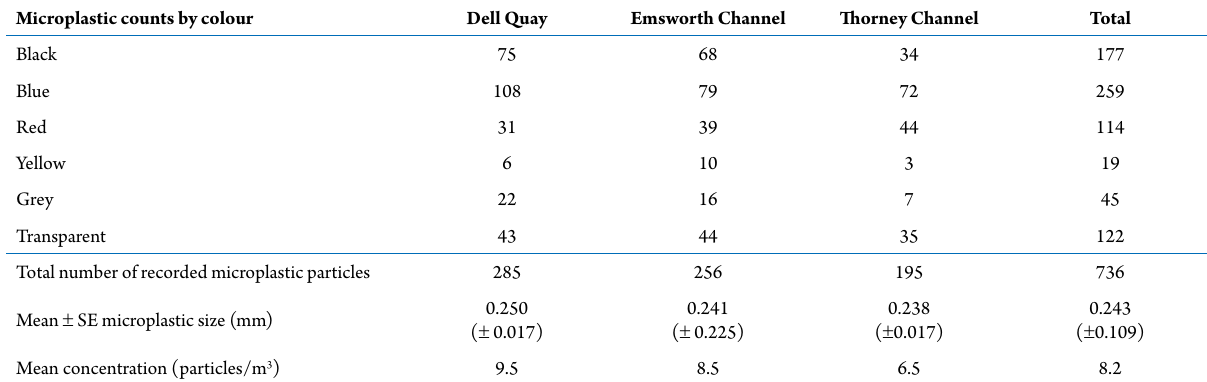
Table 2. Microplastic counts, sizes and concentrations recorded in each sampling location in Chichester Harbour Microplastic counts by